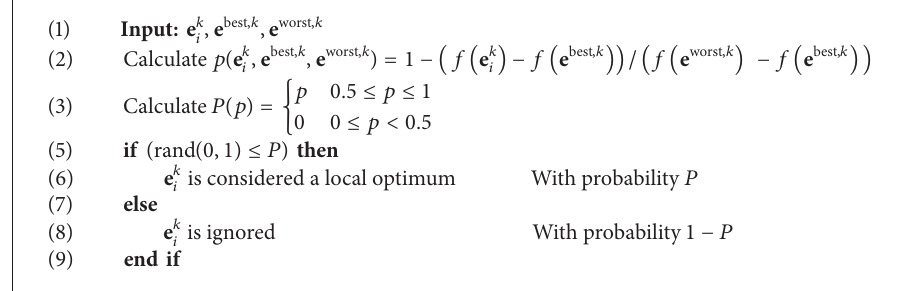
Algorithm 2: Nonsignificant fitness value rule procedure.